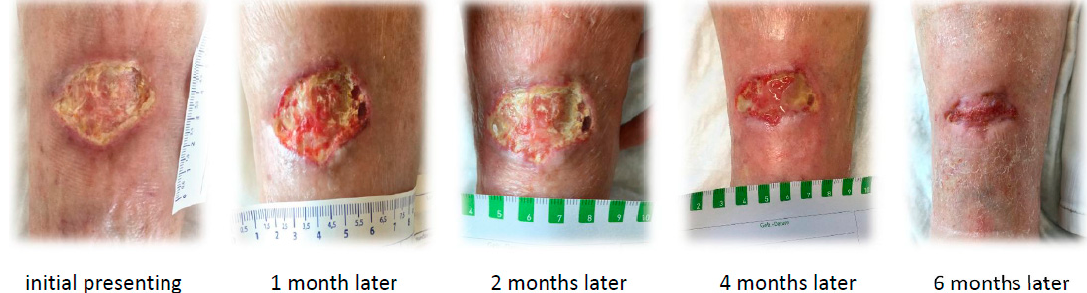
Figure 1. Initial wound finding and course of wound